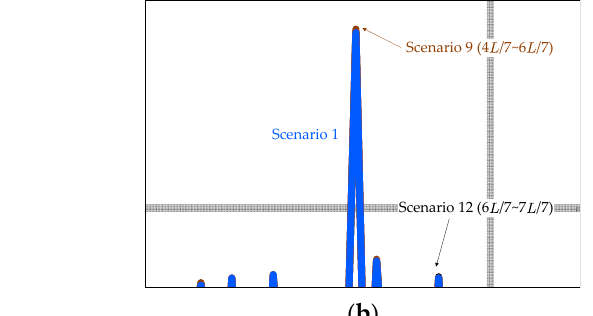
Figure A2 The acceleration responses obtained in Scenario 1: ( a ) 𝑧(cid:4663) (cid:3046)(cid:2869) ; ( b ) 𝑧(cid:4663) (cid:3046)(cid:2870) ; ( c ) 𝑧(cid:4663) (cid:3048)(cid:2869) ; and ( d ) 𝑧(cid:4663) (cid:3048)(cid:2870) . The enlarged views of Figures 6 and 7 are shown in Figure A3.